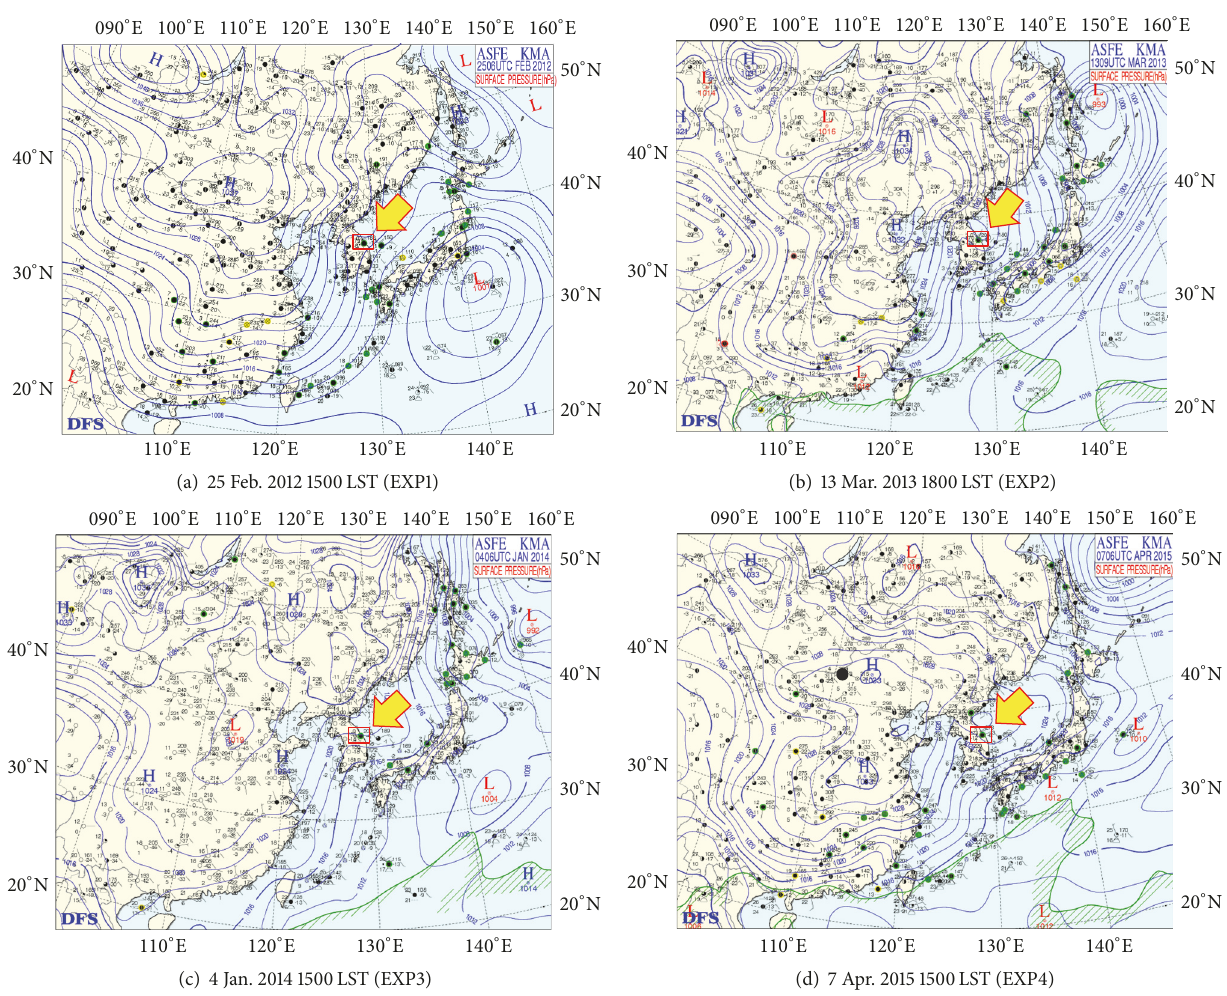
Figure 2: Synoptic weather charts for (a) EXP1, (b) EXP2, (c) EXP3, and (d) EXP4. The red box indicates the experimental region shown in Figure